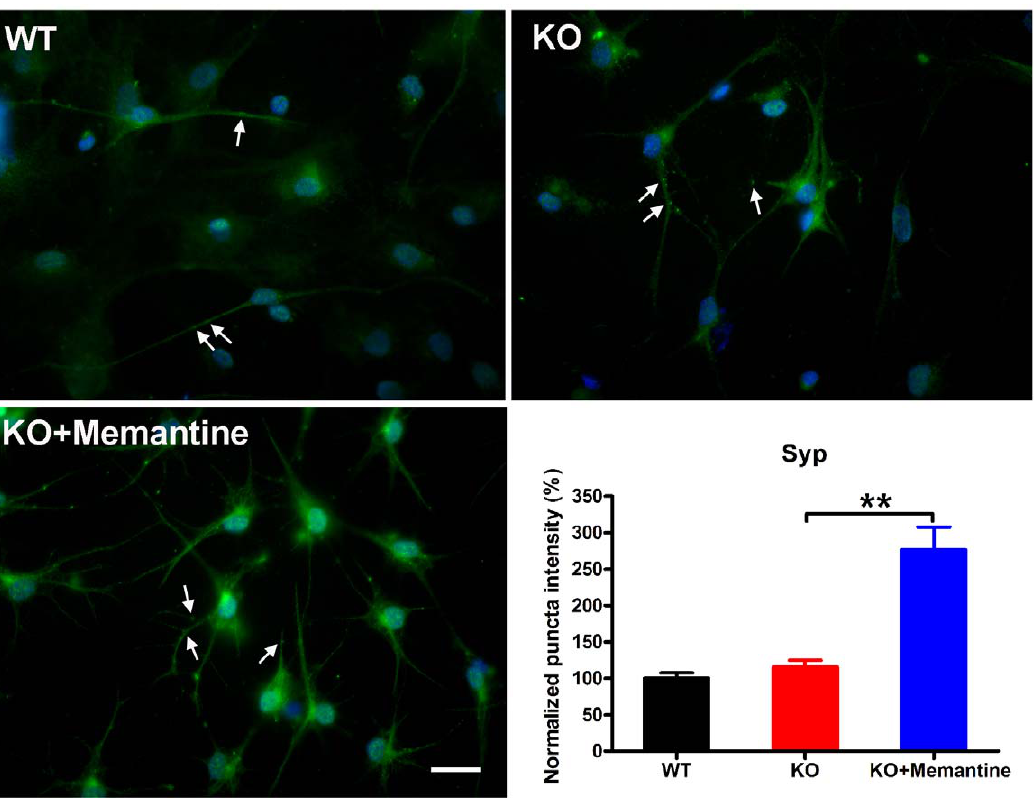
Figure 6. Memantine stimulated the formation of total synapses in Fmr1 -KO CGCs. Representative photomicrographs of labeling of Syp (arrow) in WT CGCs, Fmr1 -KO CGCs and Fmr1 -KO CGCs treated with memantine. Green, Syp; Blue, Hoechst, scale bars, 25 m m. The histogram shows quantification of puncta size using image analysis. WT, n=23; Fmr1 -KO, n=25; Fmr1 -KO + Memantine, n=26. ** p , 0.01.